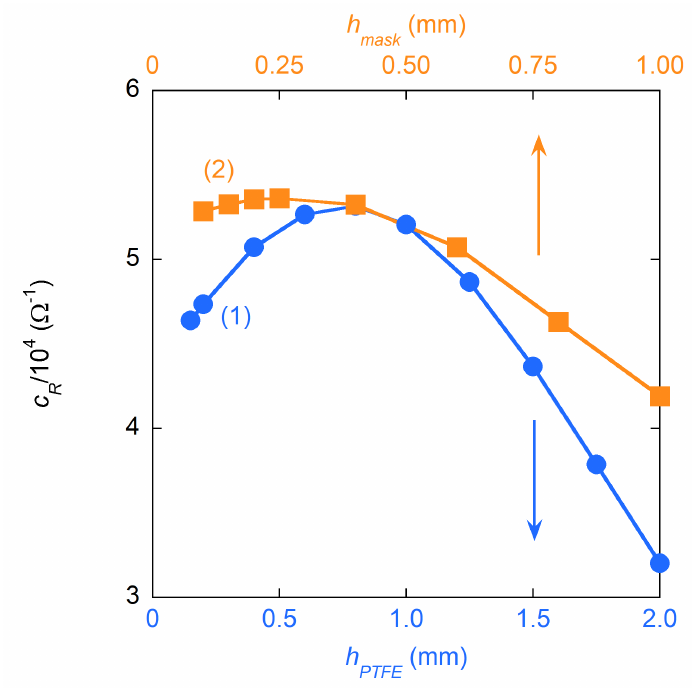
Figure 3. The measurement sensitivity is maximized through the optimization of the geometry of the resonator. Once the dimensions of the dielectric crystal are fixed, the thickness h PTFE of the PTFE layer between the crystal and the sample holder, and that of the metallic mask h mask , can be optimized. The optimization is performed with e.m. simulations by exploring the effects on the sensitivity coefficient c R = Q 2 / G s when h PTFE and h mask are varied within mechanically reasonable limits. Curve 1 (blue circles): sensitivity c R optimization by varying h PTFE (lower horizontal axis). Curve 2 (orange squares): sensitivity c R optimization by varying h mask (upper horizontal axis) once fixed h PTFE = 0.75 mm, which corresponds to the maximum c value shown in curve